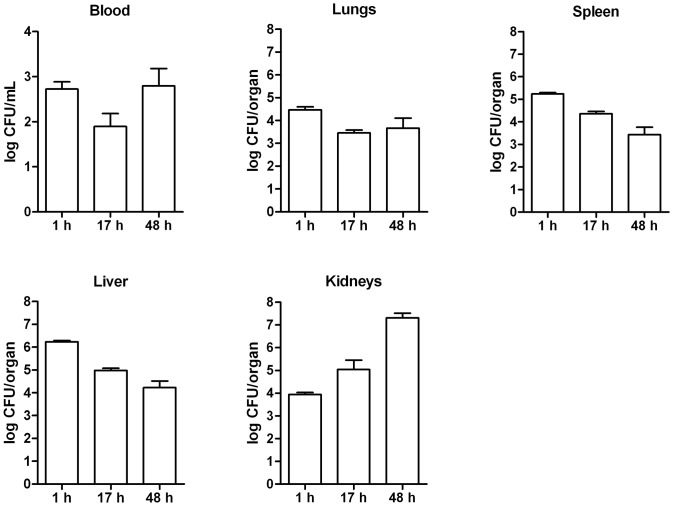

S. aureus counts in blood and organs from mice with bacteremia.At indicated time points after intravenous inoculation of S. aureus at the LD50 inoculum, mice were sacrificed and quantitative cultures of blood and organs were performed (n = 4 per time point). Results are expressed as mean ± SD (error bars). Statistically significant differences (Mann-Whitney U test) in S. aureus load were not found. h, hours.